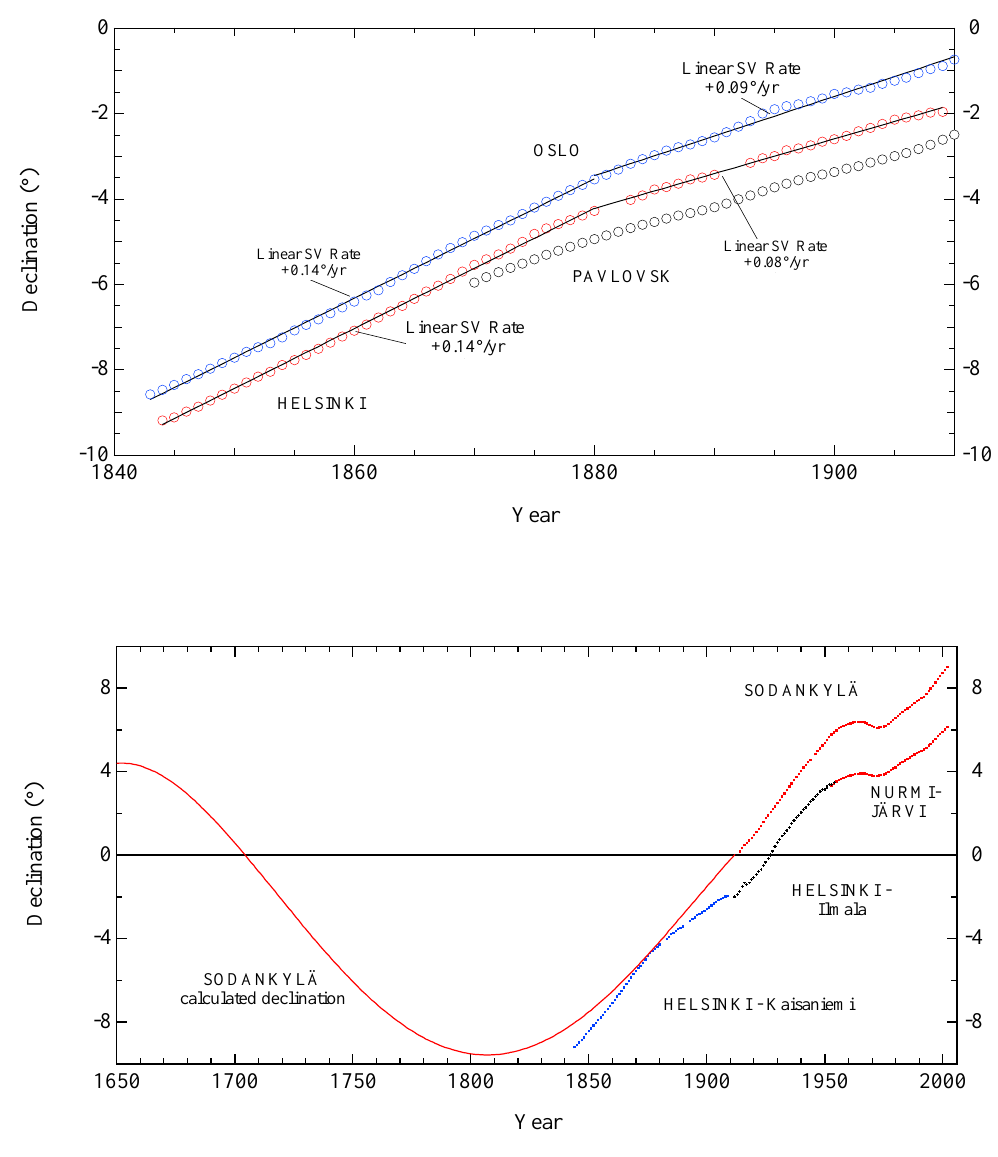
Fig. 1 Fig. 1. Upper panel: Annual means (circles) of declination from the Helsinki, Oslo (offsetted by 10 ◦ ) and Pavlovsk observatories. The secular variation (SV ) of D has been stable over 70 years during the 19th century. The linear SV rate was rather abruptly changed in the 1870s in connection with a geomagnetic jerk (Alexandrescu et al., 1997). Lower panel: Long series of the declination in Finland. The observatory series are Helsinki (Kaisaniemi), 1844–1908 and its successors Helsinki (Ilmala), 1908–1953, and Nurmij¨arvi (1953–). The Sodankyl¨a magnetic observatory series started in 1914. The solid line before 1914, continuing to the year 1650, is a polynomial ( φ,λ,t ) of declination calculated with the coordinates of Sodankyl¨a ( φ = 67 ◦ 22’N; λ = 26 ◦ 38’E). The polynomial is a fit of all magnetic survey (D) data in Finland, 1600–1950 (Nevanlinna,